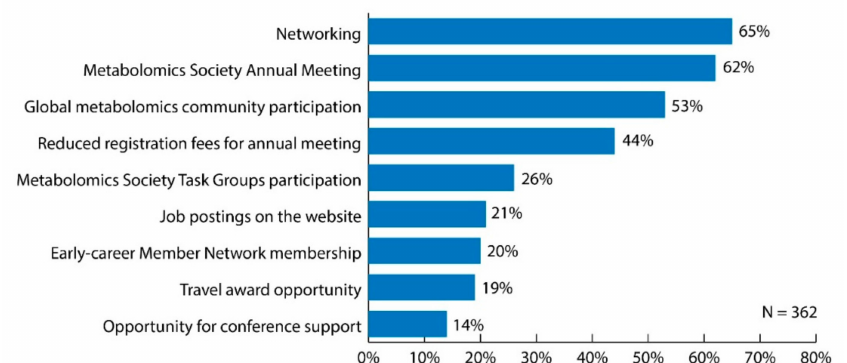
Figure 2. Bar graph of survey results for question: “What do you consider to be the most important benefits of being a Metabolomics Society member? Choose all that apply.” Original data used to create the figure can be found in the supplementary information under question number 16.